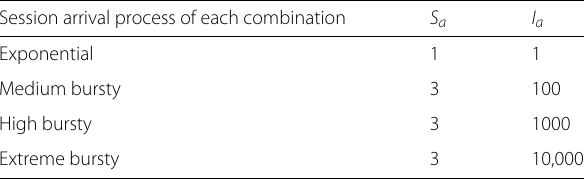
Table 5 Arrival processes of workload scenario combinations Session arrival process of each